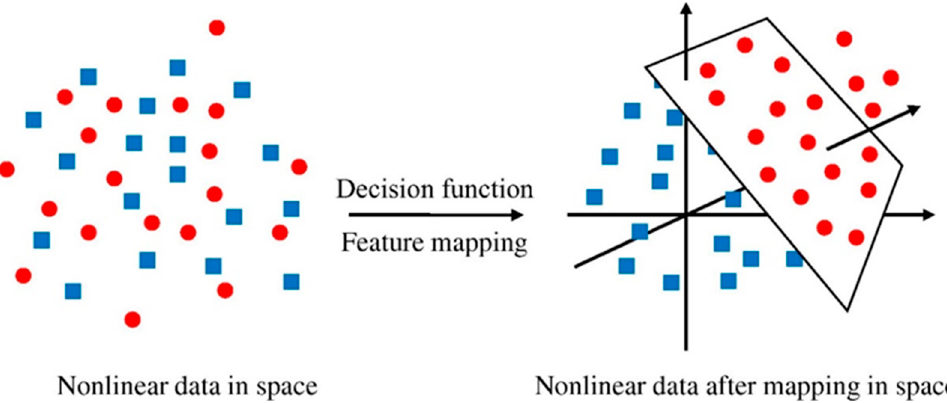
Figure 4. Model mapping of the support vector machine algorithm [64].